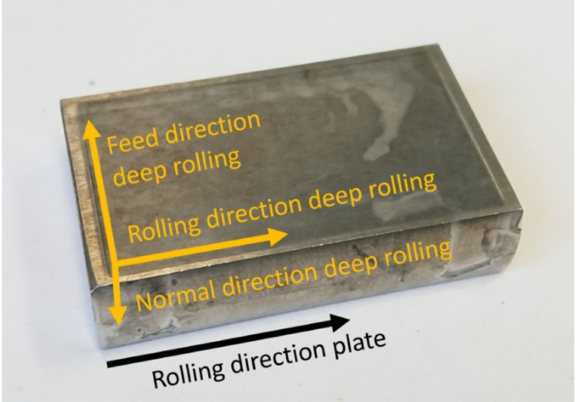
Figure 2. Sample geometry and assignment of the sample coordinate system.